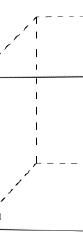
Figure 1. Rhombohedral crystallographic structure.